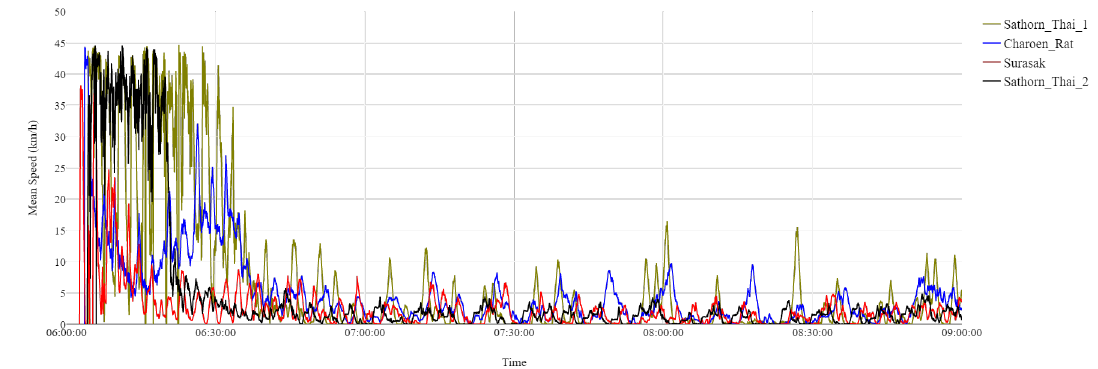
Figure 6. Mean speed of the upstream links (Sathorn_Thai_1, Charoen_Rat, Surasak) and downstream link (Sathorn_Thai_2) at the Surasak intersection.